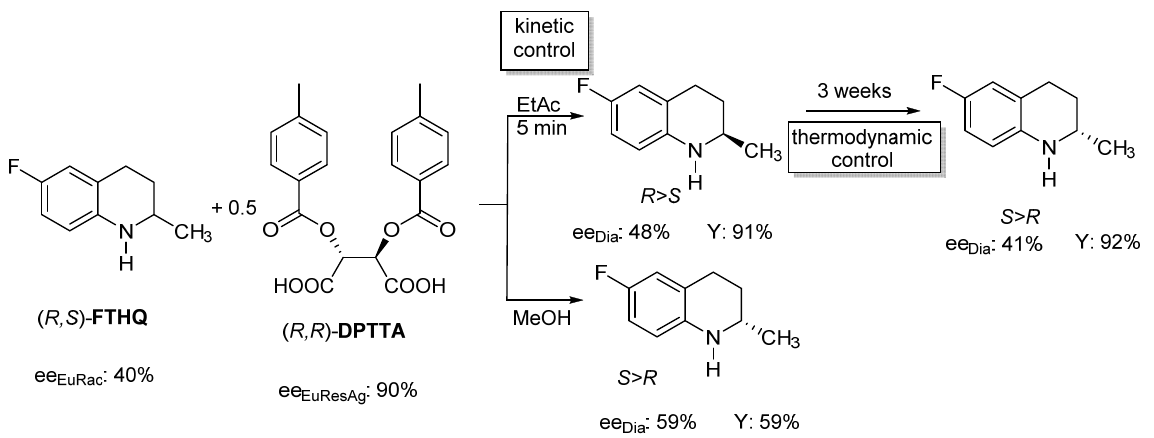
Figure 4. Resolution of racemic FTHQ with DPTTA resolving agent, in different solvents and the effect of kinetic or equilibrium thermodynamic control.